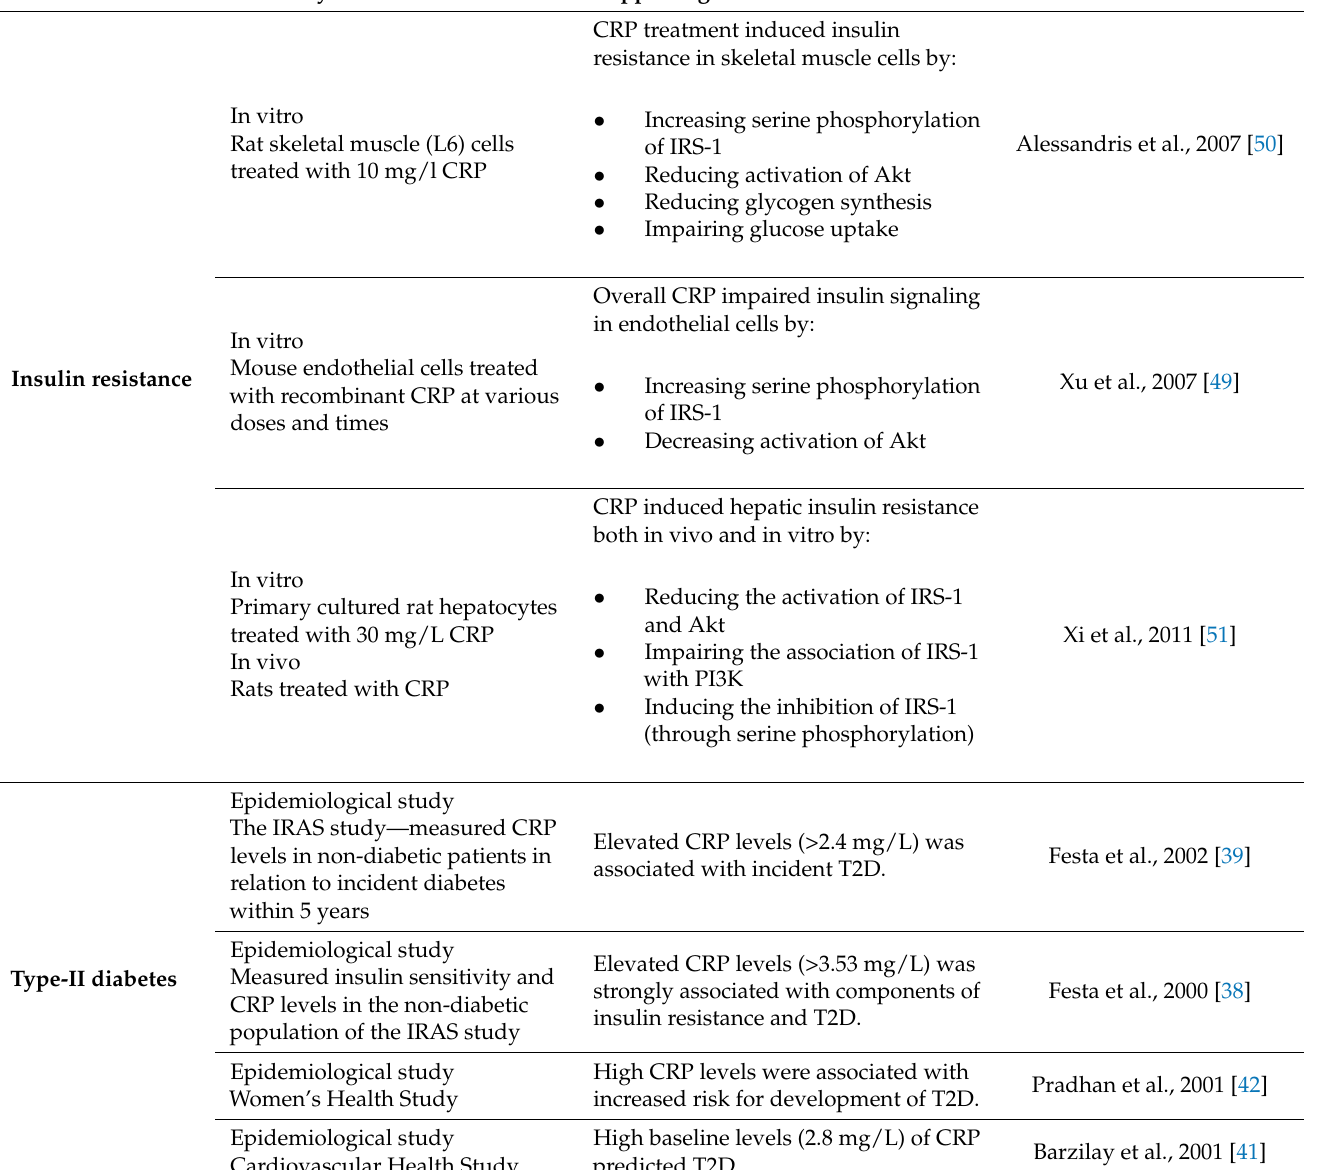
Table 3. Studies supporting the role of CRP in the development of insulin resistance and type-2 diabetes. Disease